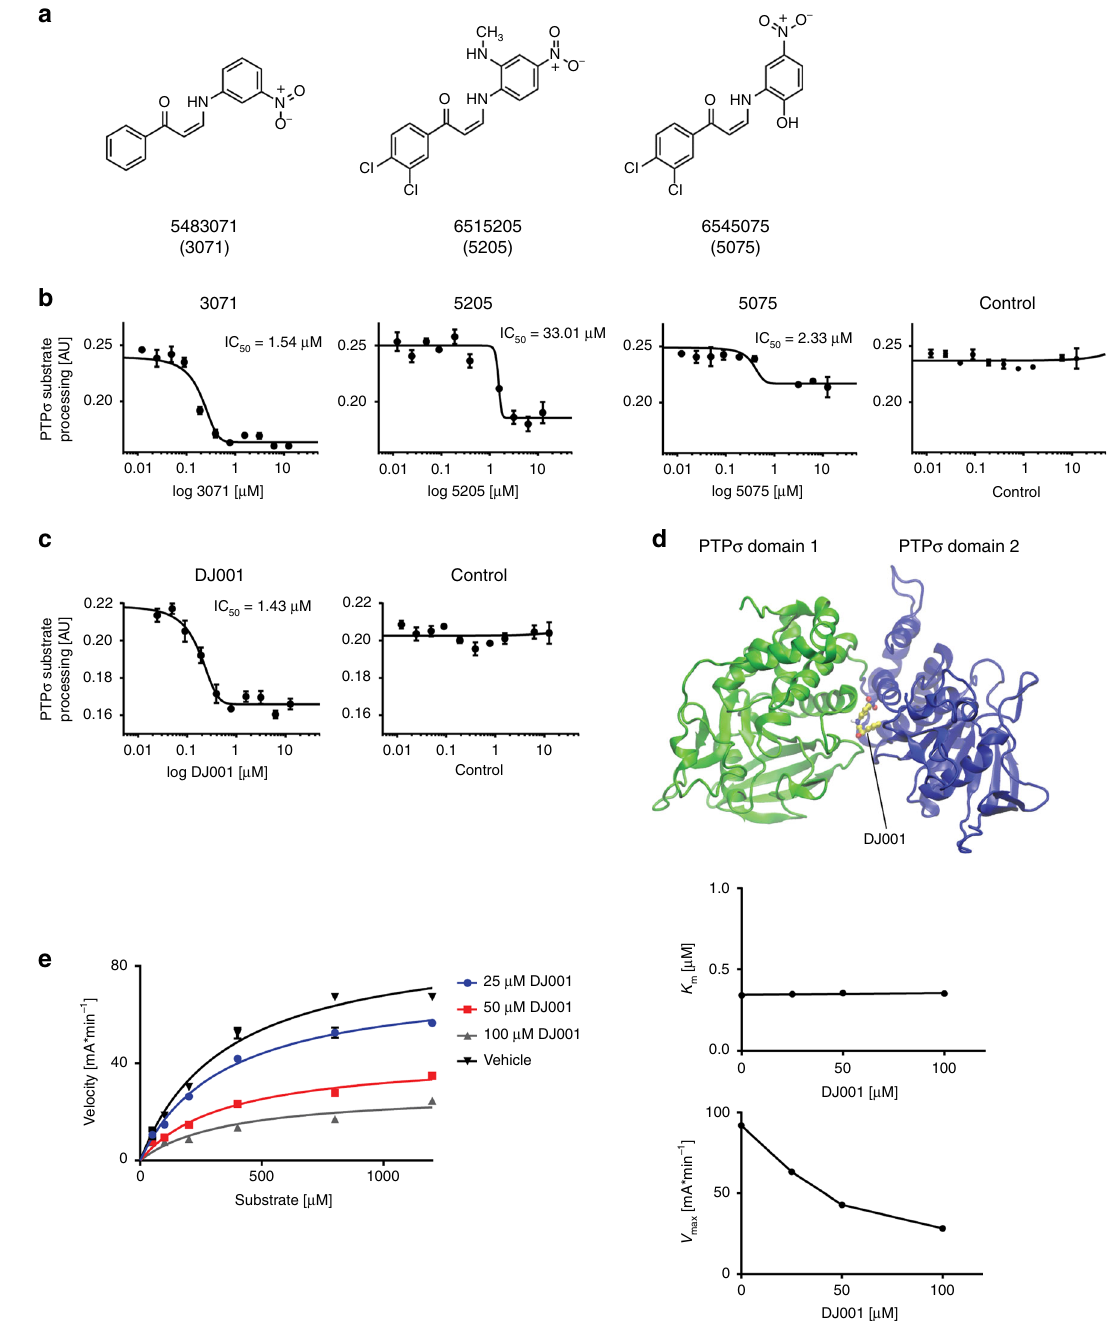
Fig. 1 DJ001 is a non-competitive, allosteric inhibitor of PTP σ . a Chemical structures of compounds 3071, 5205, and 5075. b Concentration-inhibition curves and IC 50 values for 3071, 5205, 5075, and control (DMSO) following incubation with PTP σ ( n = 3). c Concentration-inhibition curves and IC 50 values for DJ001 and control following incubation with PTP σ ( n = 3). d In silico three-dimensional docking of DJ001 ( Z isomer) (represented as ball and stick in yellow color) to the PTP σ allosteric binding site located between domain 1 (green) and domain 2 (blue) of PTP σ . e At left, substrate titration reveals DJ001 as a non-competitive inhibitor that inhibits substrate catalysis ( V max ), but not substrate binding of PTP σ (constant K m ). At right, plots of K m and V max as a function of compound concentration delivered from nonlinear regression in substrate titration. Error bars represent SEM. Source data are provided as Source Data